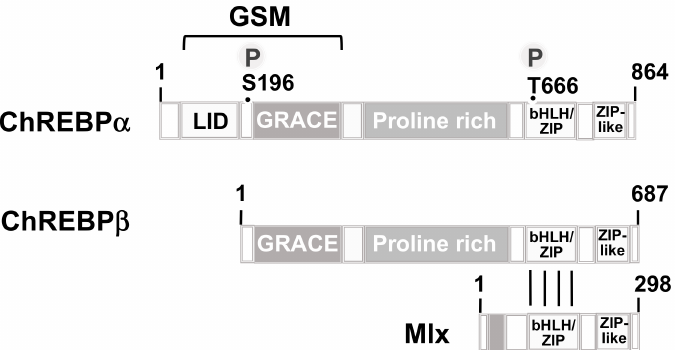
Figure 5. Modular structure of ChREBP α , ChREBP β , and Mlx. The ChREBP proteins contain a C-terminal helix-loop-helix/zipper domain (bHLH-ZIP) that is used for binding to DNA and for dimerization with Mlx. The C-termini contain a leucine zipper-like domain (ZIP-like). The N-terminal glucose-sensing module (GSM), composed of a glucose-inhibitory domain (LID) and a glucose-response activation conserved element (GRACE), is depicted along with two phosphorylation sites for cAMP-dependent protein